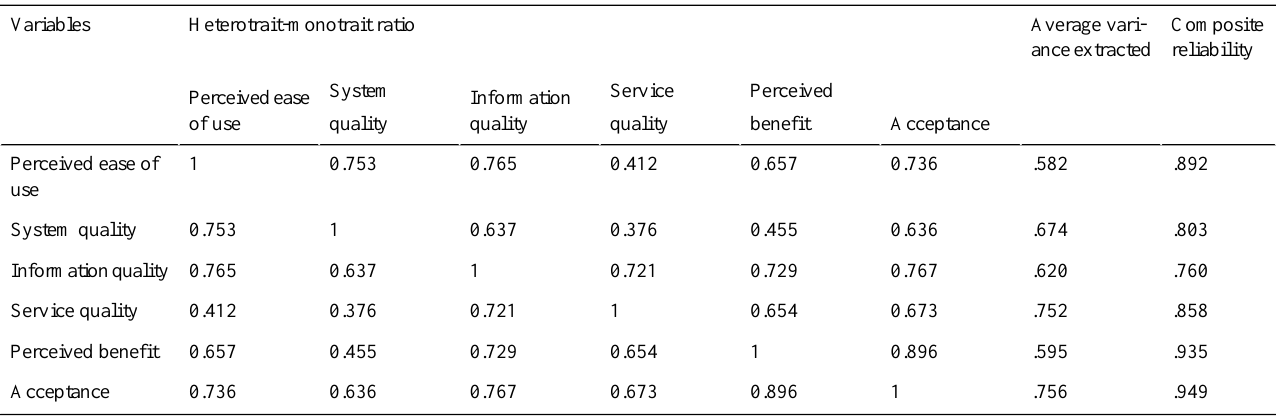
Table 3. Internal consistency, convergent validity, and discriminant validity of